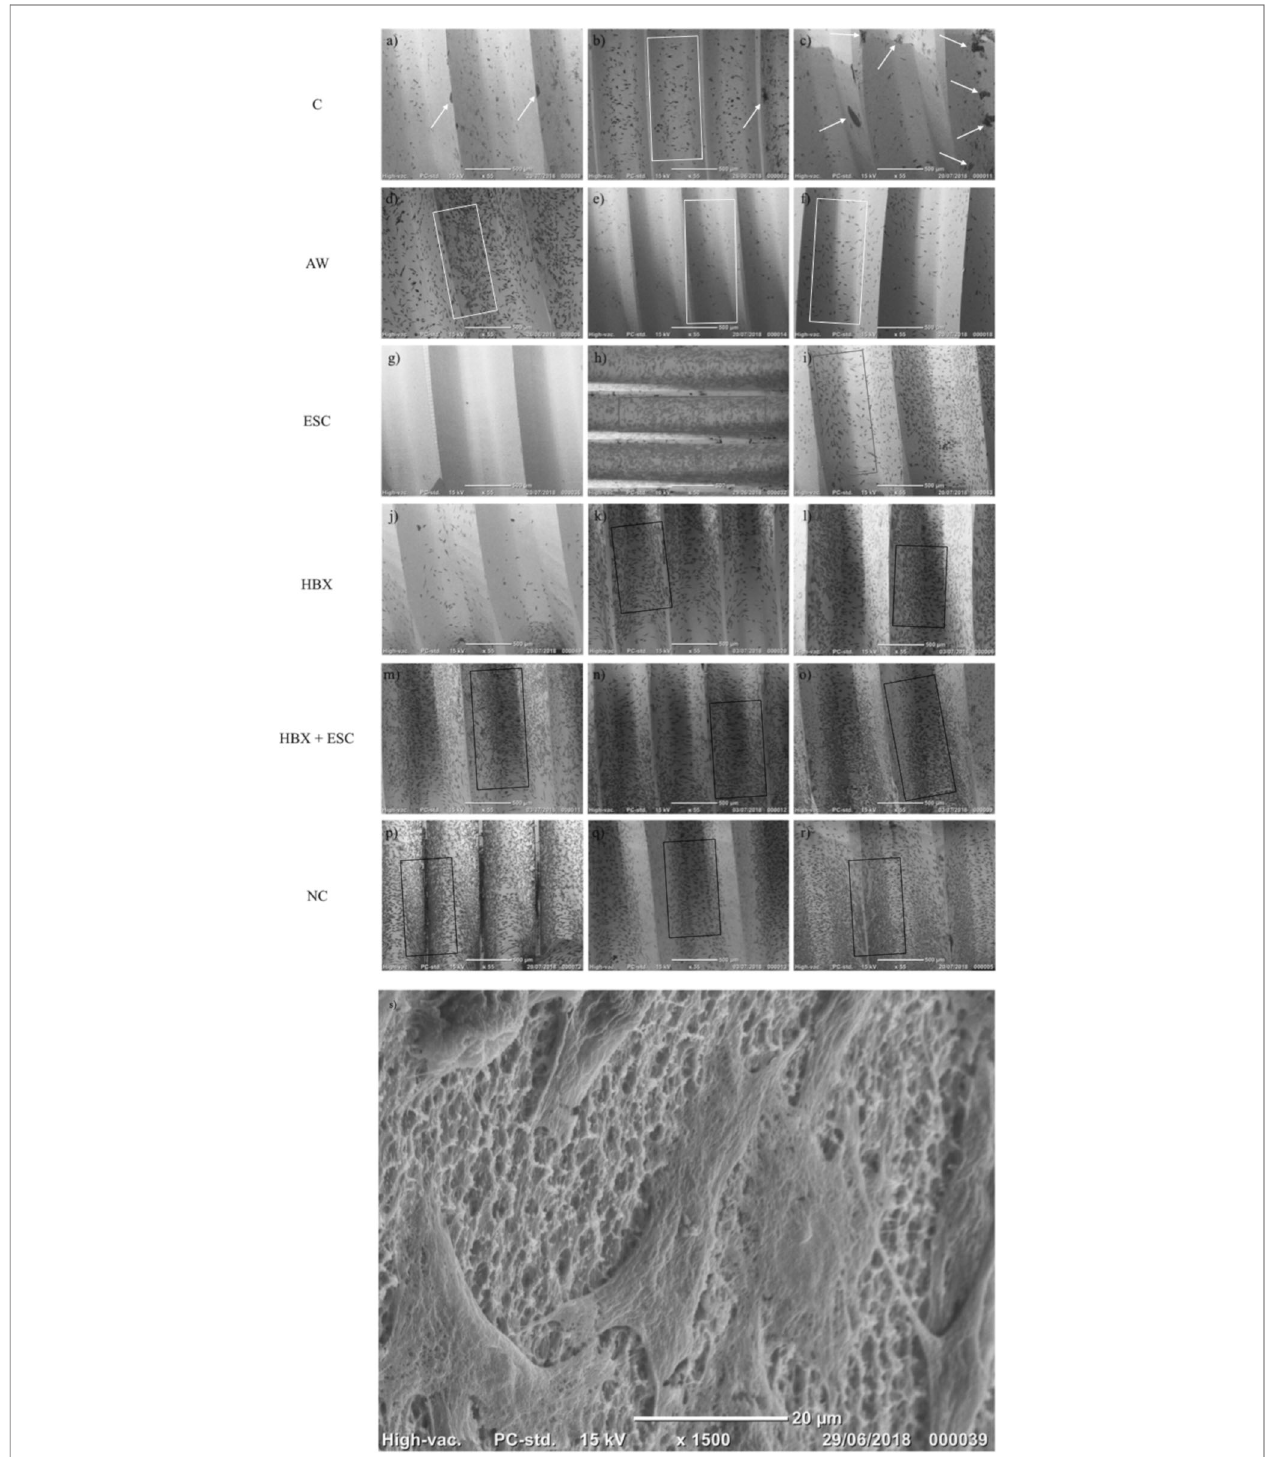
FIGURE 3 | 55× microphotographs of the implants from different experimental groups. White arrows, bacterial aggregates; white boxes, spread cells between implant threads; red boxes; non densely packed cells; black boxes, densely packed cells. C, control group – no treatment ( A – C ); AW, air-abrasive device without powder ( D – F ), ESC, air-abrasive device with powder of erythritol, amorphous silica and 0.3% chlorhexidine ( G – I ), HBX, sulfonic/sulfuric acid solution in gel alone ( J – L ), HBX + ESC, sulfonic/sulfuric acid solution in gel followed by air-abrasive device with powder of erythritol, amorphous silica and 0.3% chlorhexidine ( M – O ); NC, non contaminated, non treated implants ( P – R ). ( S ) Details of MG-63 cells adhering on a previously contaminated and subsequently treated implant surface